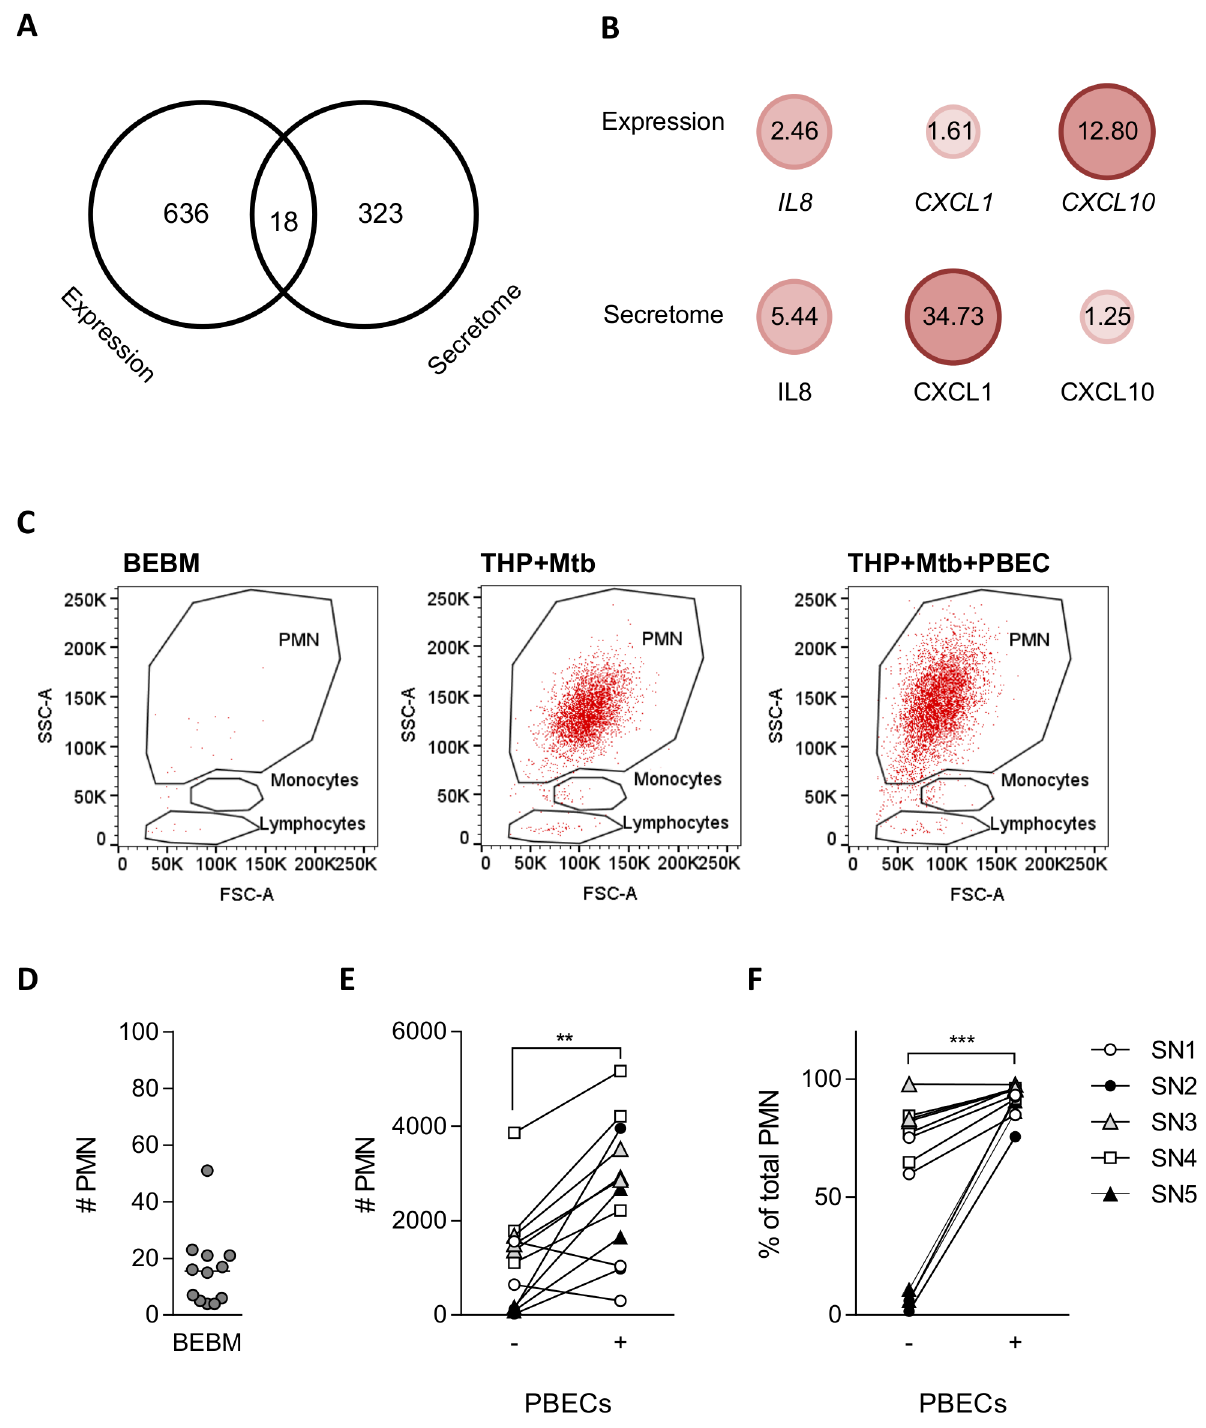
Fig 9. PBECs upregulate chemokines and enhance neutrophil recruitment to the site of Mtb-infection. (A) The Venn diagramme shows the overlap betweensignificantly inducedgenesin PBECs exposedto Mtb-infected THP-1 cells at 24h (Expression) and significantlyincreasedsecreted proteinsduringinfected PBEC-THP-1 co-culture over infected THP-1 monoculture at 48h (Secretome). Three of the overlappingproteinswere associated with chemotaxis (GO:0006935) and their fold changesin their respectivecomparisons are shown in (B). PBLs were added into a transwellinsert on top of a culture well containingconditioned medium from Mtb-infectedTHP-1 cells ± PBECs or medium control (BEBM). Supernatants were generatedfrom five different PBEC donors(SN1-5). After 3 h cells from the insert and the bottom well were collectedand enumerated by flowcytometry. (C) Shows representative plots of the gating strategy to define